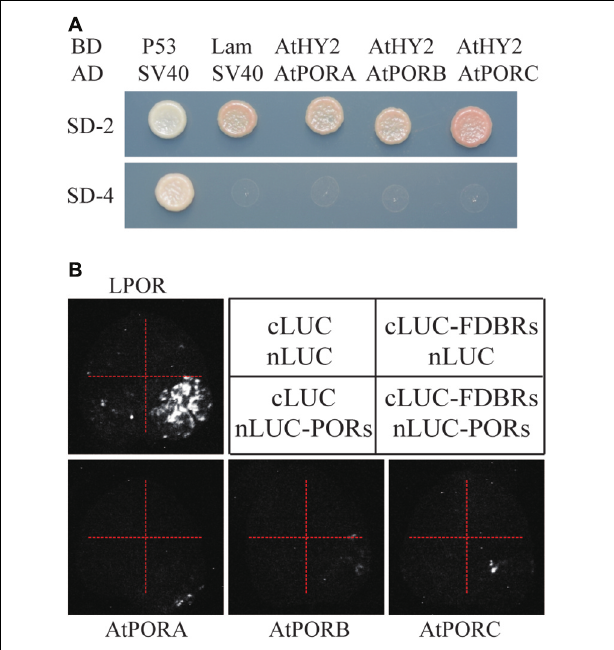
FIGURE 3 | Arabidopsis FDBR protein AtHY2 does not interact with Arabidopsis PORs. (A) Yeast two-hybrid assay for the interaction of AtHY2 with AtPORA, AtPORB and AtPORC. Putative chloroplast transit peptides of these chloroplast-localized proteins were removed. (B) Split-luciferase assay for the interaction of AtHY2 with AtPORA, AtPORB, and AtPORC (lower three images). Co-expression of cLUC and nLUC, cLUC-AtHY2 and nLUC, cLUC and nLUC-AtPORA/AtPORB/AtPORC in tobacco leaves were used as negative controls. Co-expression of cLUC-PCYA1 and nLUC-LPOR was used as a positive control (upper image).